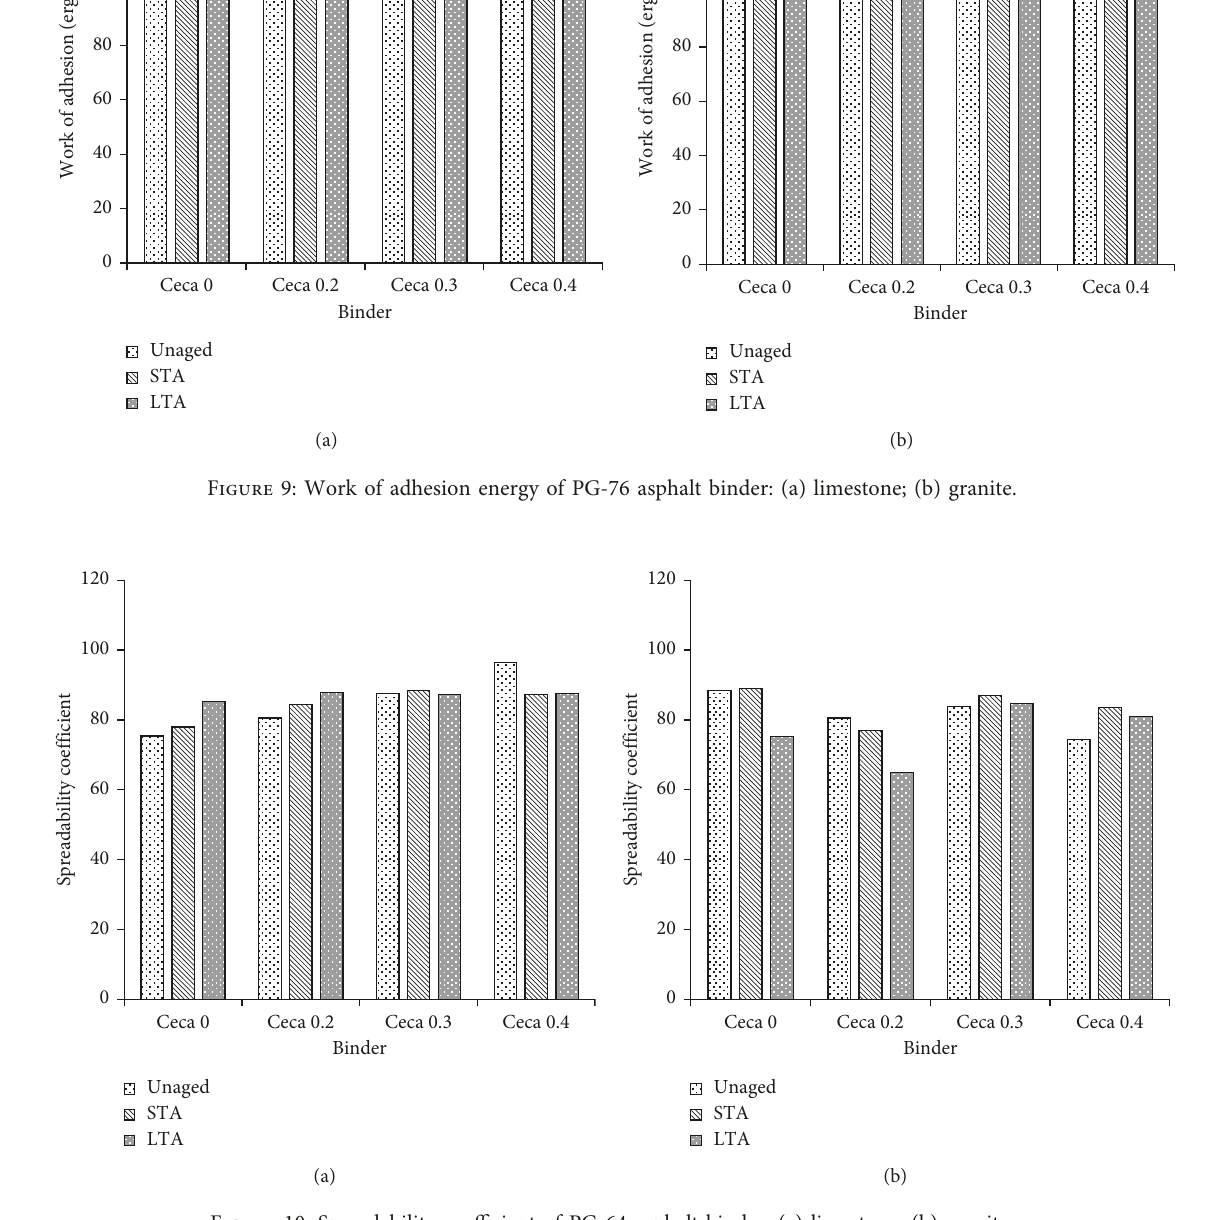
Figure 10: Spreadability coefficient of PG-64 asphalt binder: (a) limestone; (b)